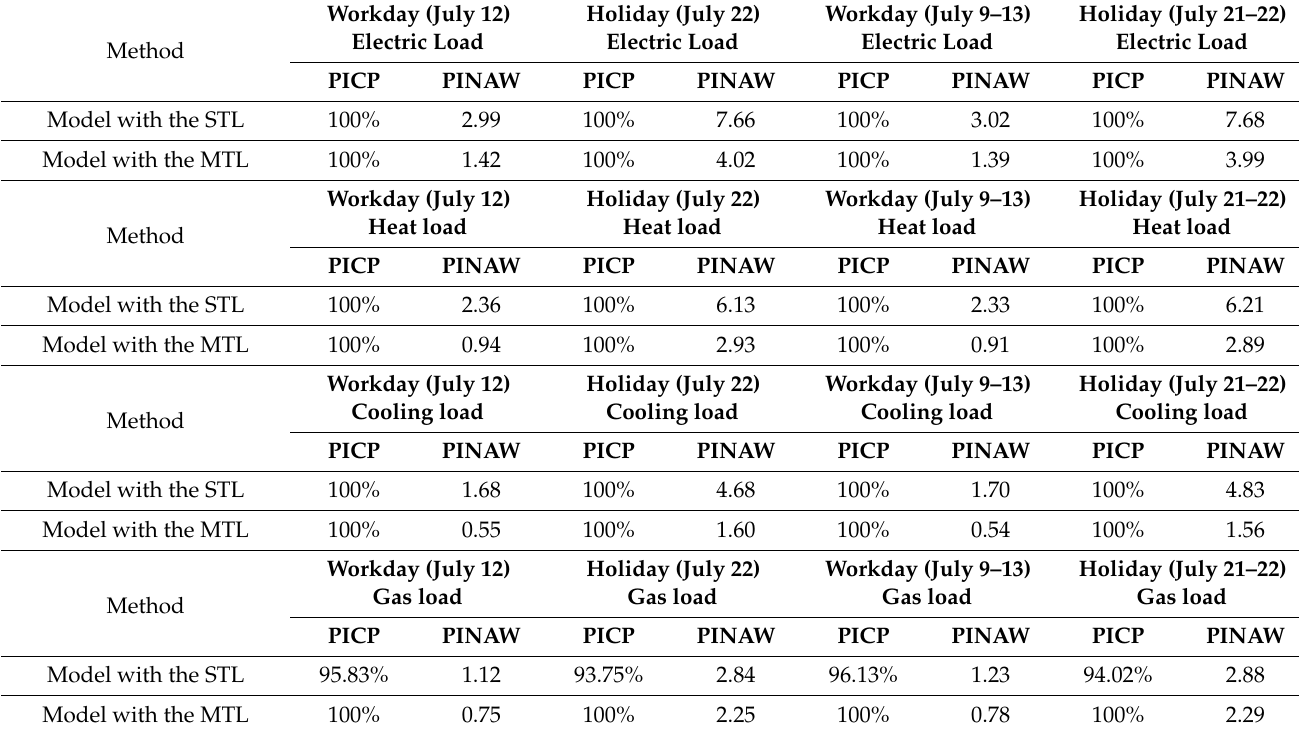
Table 2. Prediction performance comparison of two models with the STL method and the MTL method.